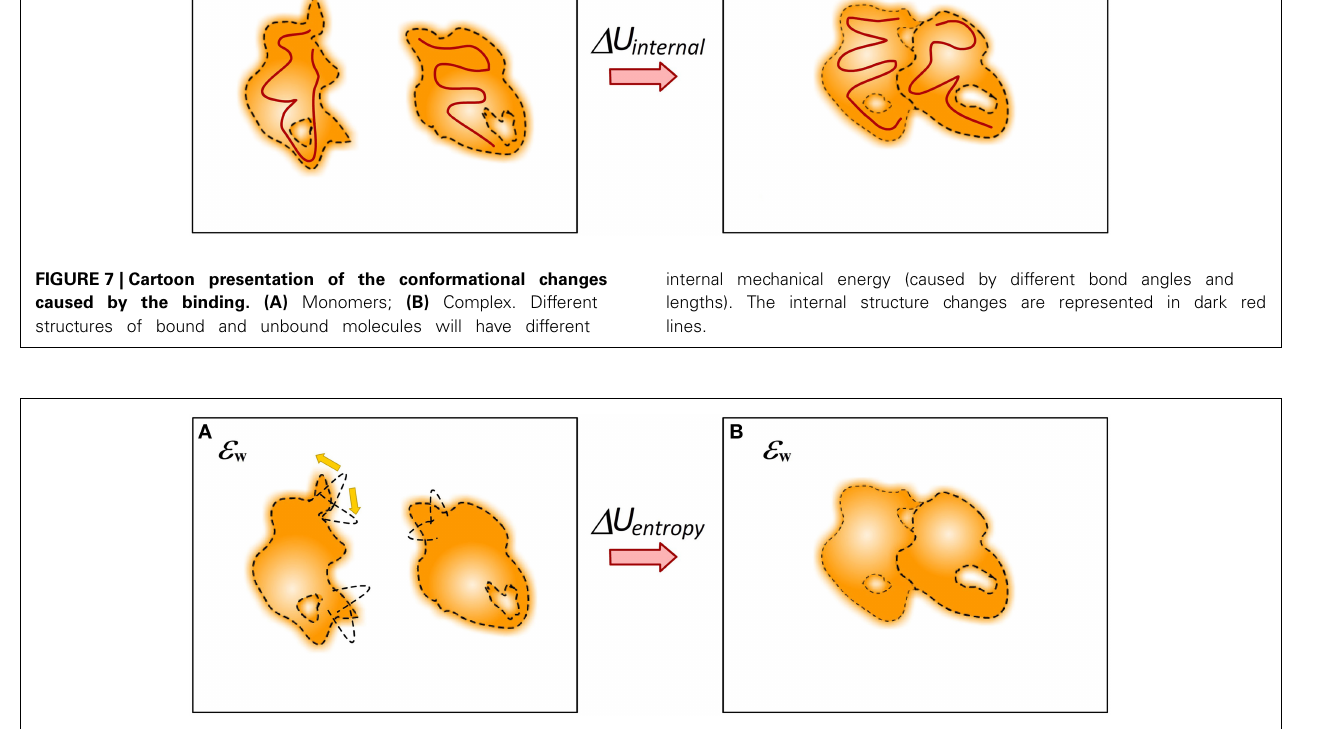
FIGURE 8 | Schematic presentation of changes of the dynamics of molecules upon the binding. (A) Monomers; (B) Complex. The molecule can be quite flexible before binding but to adopt rigid conformation in the complex.